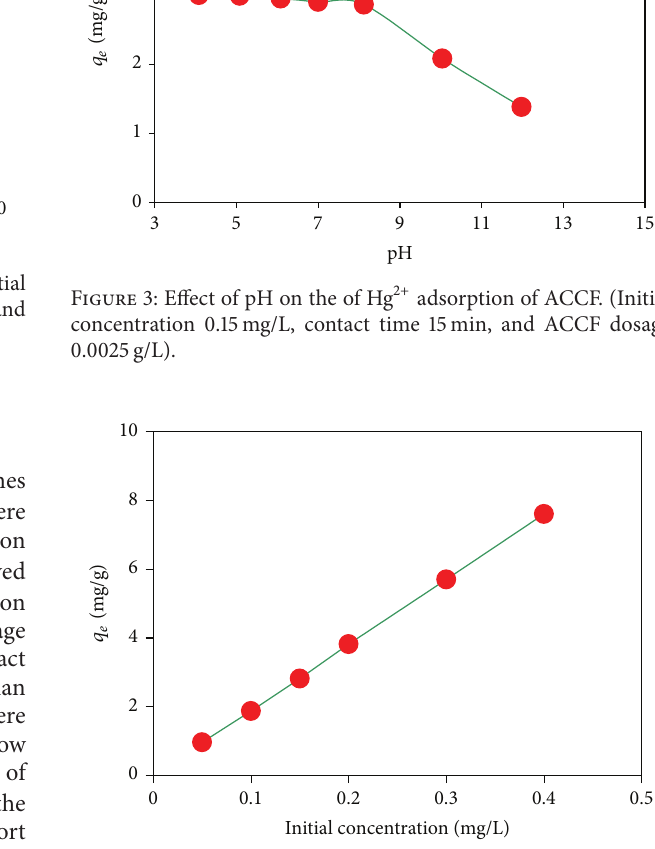
Figure 4: Effect of initial Hg concentration on the of Hg 2+ adsorptionofACCF.(ACCFdosage0.0025g/L,pH4.08,andcontact time